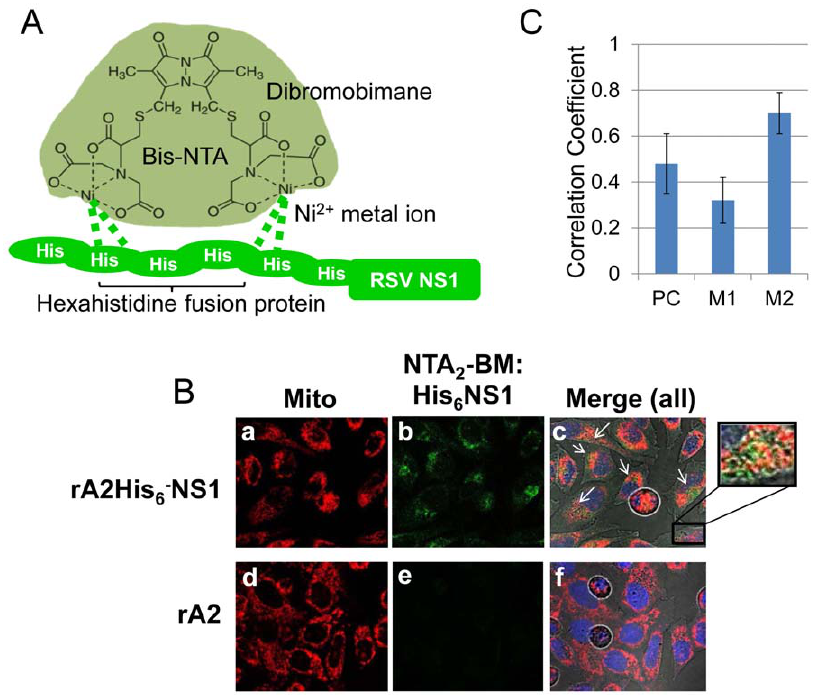
Figure 2. Co-localization of His 6 -NS1 with mitochondria in infected cells using Ni 2 + -NTA 2 -BM. ( A ) Structure of Ni 2 + -NTA 2 -BM [26]. ( B ) rA2- His 6 -NS1 or rA2 were used to infect HEp-2 cells at a MOI of 2. At 10h p.i., infected cells were labeled with CMXRos (red), DRAQ5 (blue), and 50 m MNi 2 + -